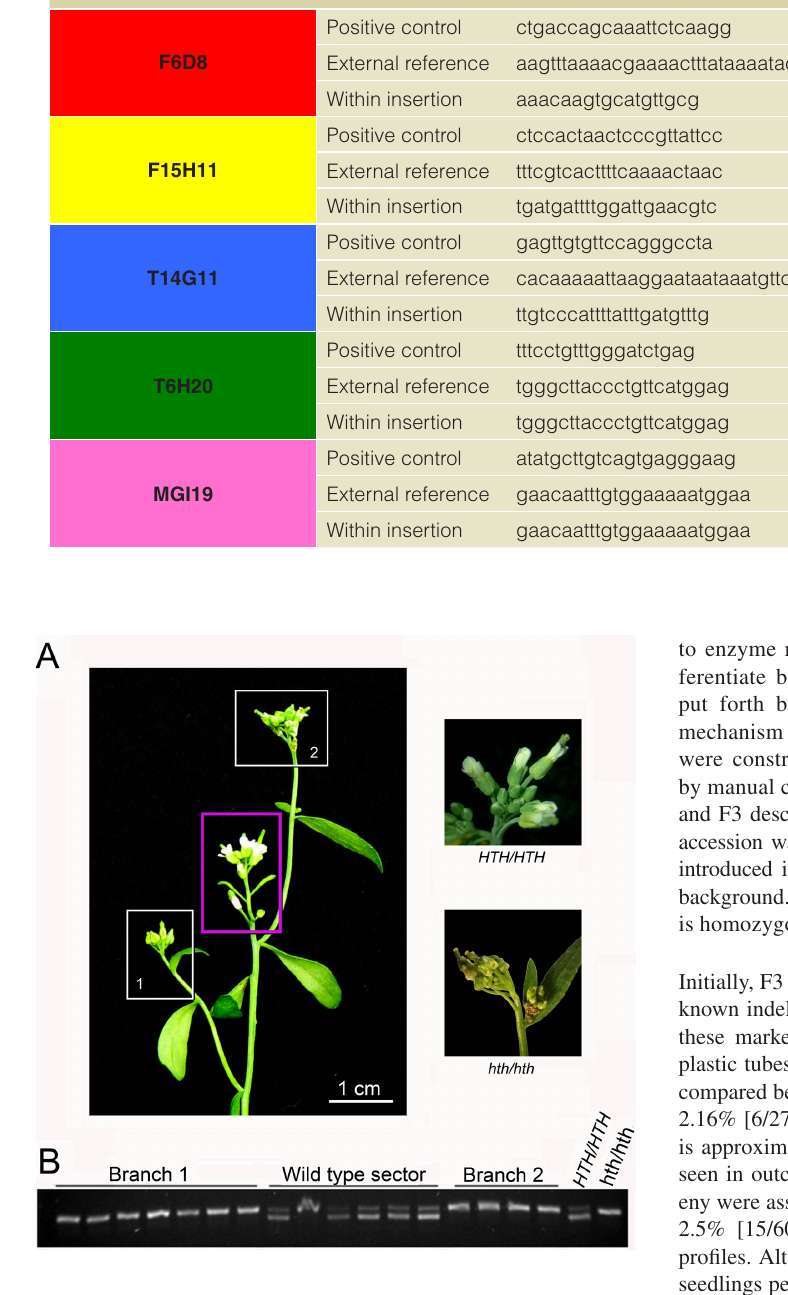
Figure 2. Molecular analysis of a mutant hth-4 plant showing a large wt sector. ( A ) Two mutant branches (white boxes) flank a phenotypically wt flower branch (magenta box). Examples of normal wt ( HTH/HTH ) and mutant ( hth/hth ) flowers are shown on the right. ( B ) DNA was extracted from tissue samples and allele-specific PCR-based molecular markers used to determine genotype. The wt branch scored as heterozygous ( hth-4/HTH-4 ), while mutant branches scored as homozygous for the hth-4